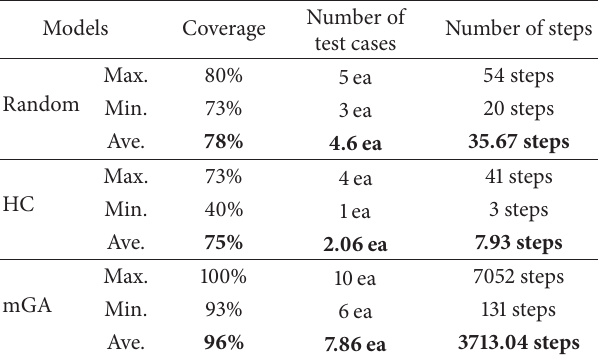
Table 4: The result of test case